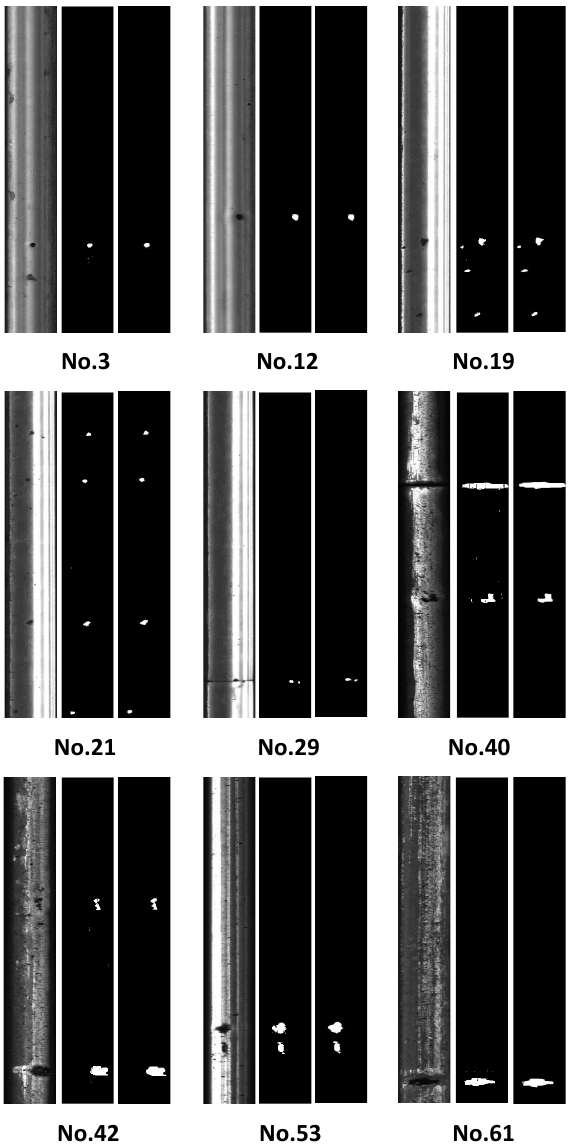
Figure 5. Example rails in the validation set, with label Nos. 3, 12, 19, 21, 29, 40, 42, 53, and 61 in the Type-I RSDD dataset. The sequence of each rail images is the original image, the learning result, and the ground